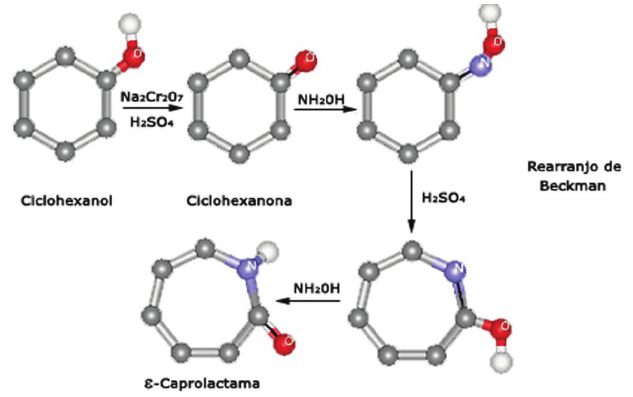
FIGURA 1 – Reação de obtenção da caprolactama (Molecular Simulations,